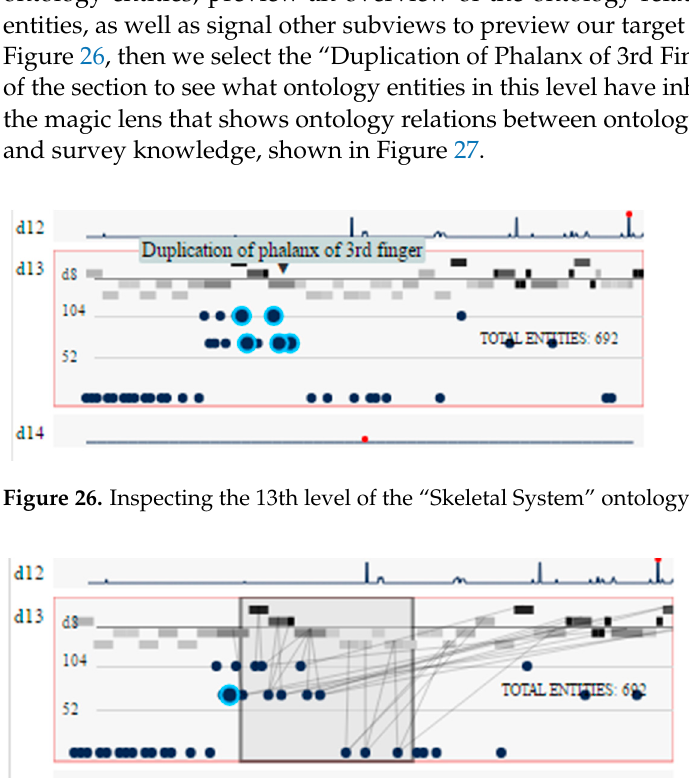
Figure 25. An overview of the Section Levels Panel subview depicting the “Skeletal System” ontol- ogy section levels after navigating from the Ontology Sections Panel subview.